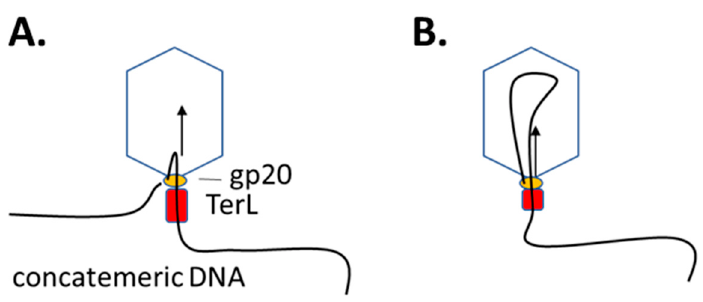
Figure 2. Packaging of concatemeric DNA into the T4 head. One end of the DNA is held at the gp20 portal, whereas the free strand is funneled through the portal as a loop structure ( A ) by sequential movements of the TerL subunits and hydrolysis of ATP ( B